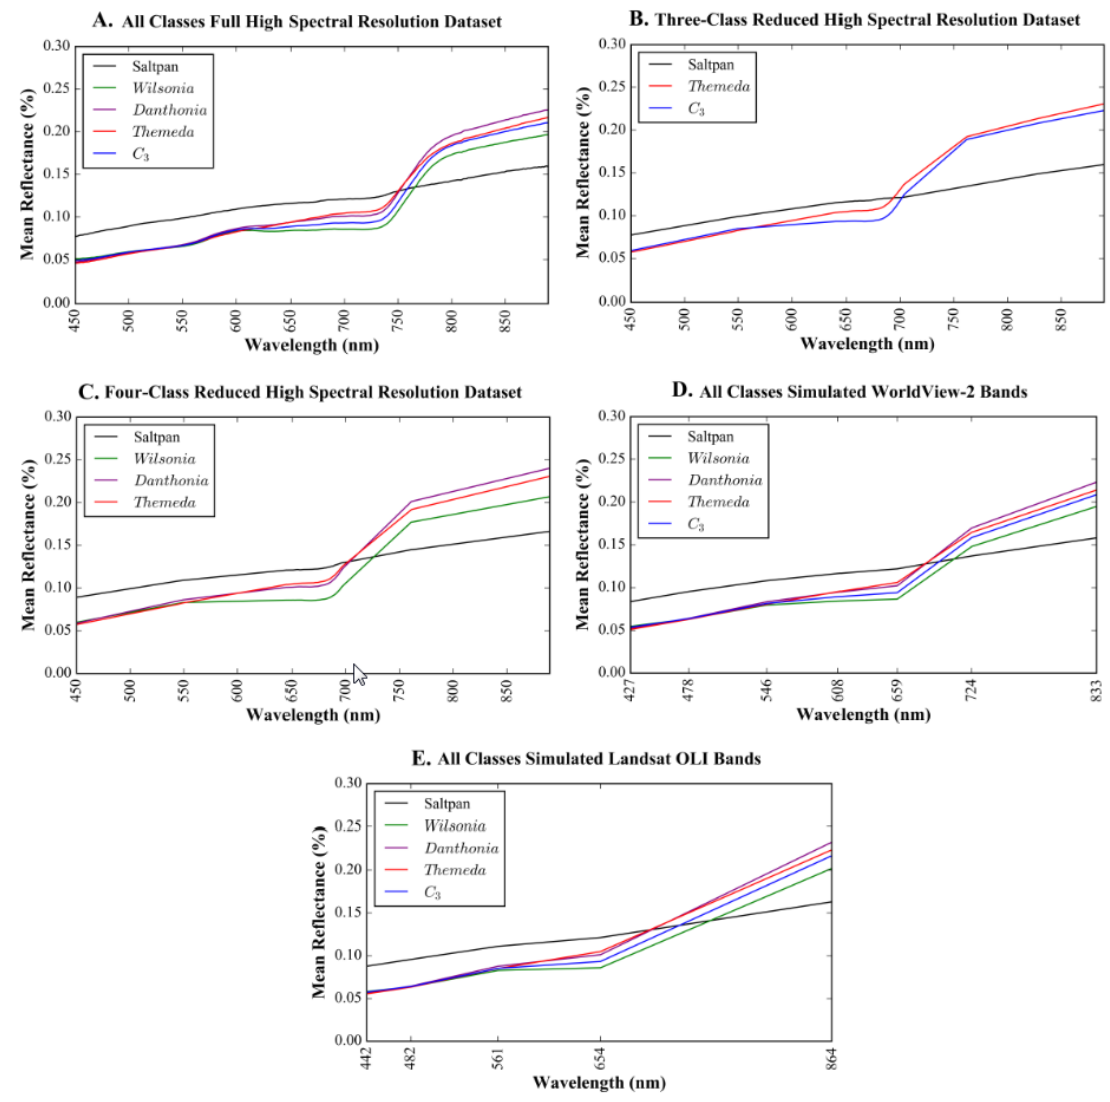
Figure 3. Mean spectral signatures for all classes in each dataset. Sub-figures ( A ) to ( E ) show the behavior of the land cover classes in the various datasets as spectral resolution changes. Landsat OLI and WorldView-2 mean spectra are plotted against the centre wavelength of each respective band.